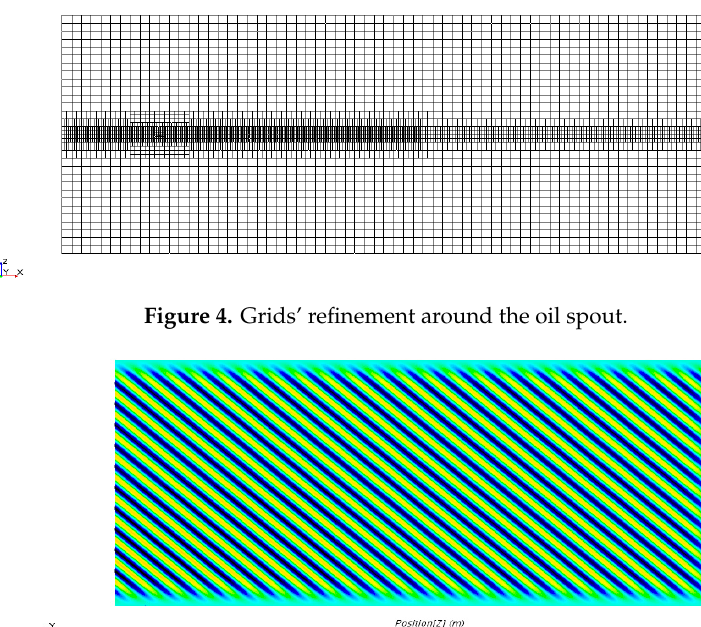
Figure 4. Grids’ refinement around the oil spout. Figure 5. Initialization of free surface Figure 5. Initialization of free surface wave.